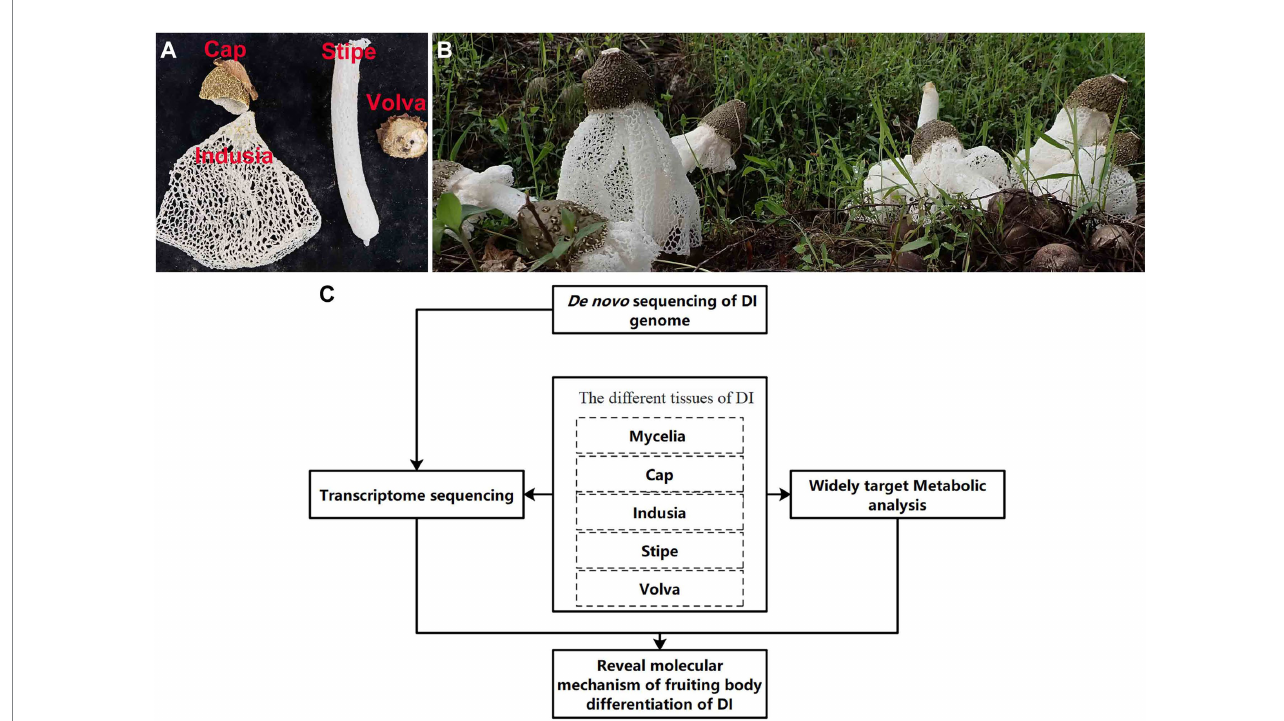
FIGURE 1 Apparent morphology of DI fruiting bodies and technical route of the study. (A) Different kinds of DI tissues used in this study. (B) Morphology of DI fruiting bodies at harvest. (C) The technical route of this